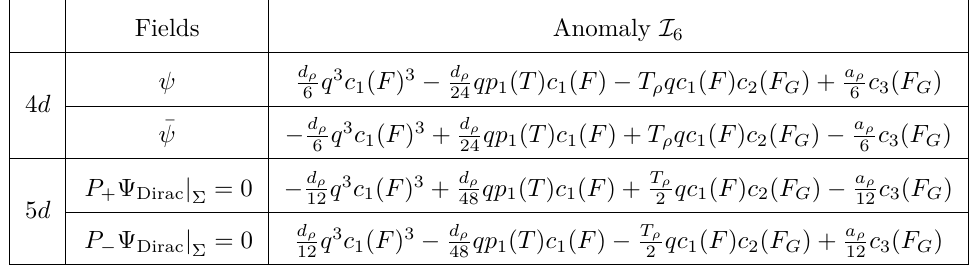
Table 1 . The ’t Hooft anomalies contributed by a 4d Weyl fermion ψ and its conjugate ¯ ψ , and a 5d Dirac fermion Ψ Dirac with different boundary conditions. Both ψ and Ψ Dirac carry charge q under the U(1) symmetry and transform in an irreducible representation ρ for the nonabelian G symmetry. The dimension, Dynkin index and cubic Casimir eigenvalue for ρ are denoted by d ρ , T ρ and a ρ respectively. The background gauge connections for U(1) × G are A and A G